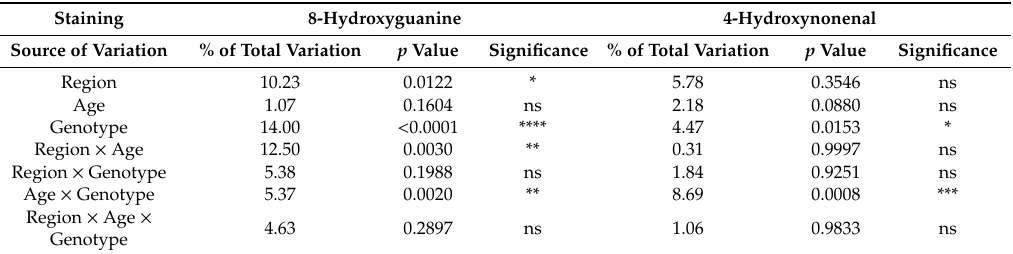
Table 2. Statistical analysis of the staining quantification. The 3-way ANOVA was followed by Tukey’s multiple comparisons test performed using GraphPad Prism version 8.0.1 for Windows, GraphPad Software, San Diego, CA,